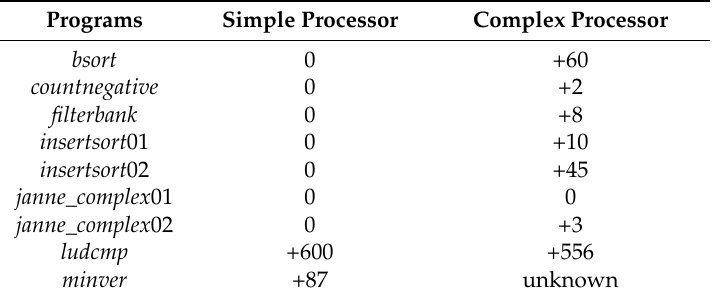
Table 6. The difference between reduced WCET and correct WCET (unit: cycle).